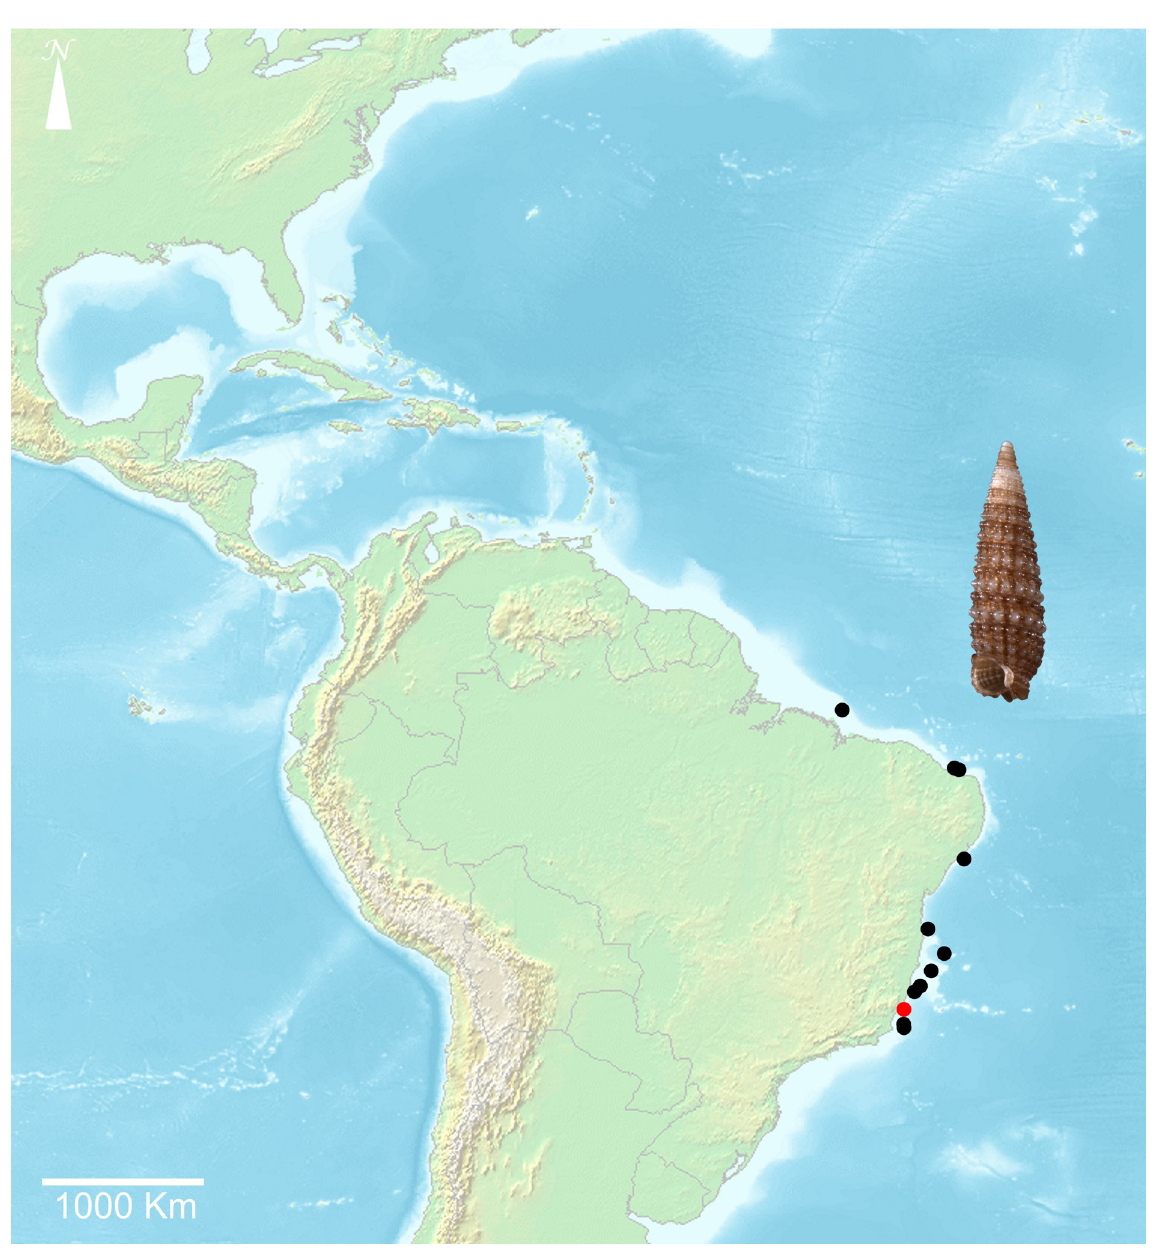
Fig. 81. Distribution map of Triphora scylla Fernandes & Pimenta, 2015; red circle = type